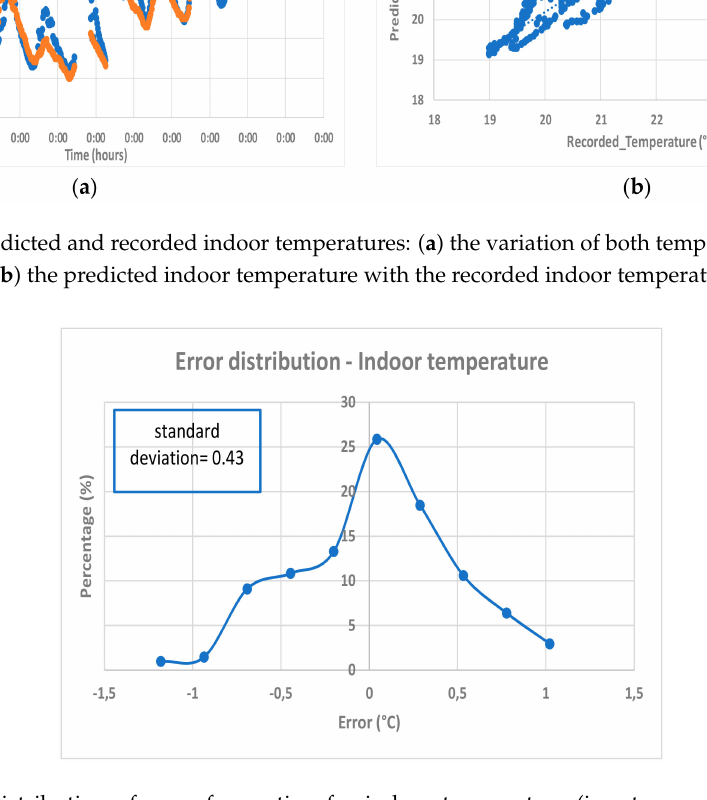
Figure 13. Distribution of error forecasting for indoor temperature (input parameters = facade